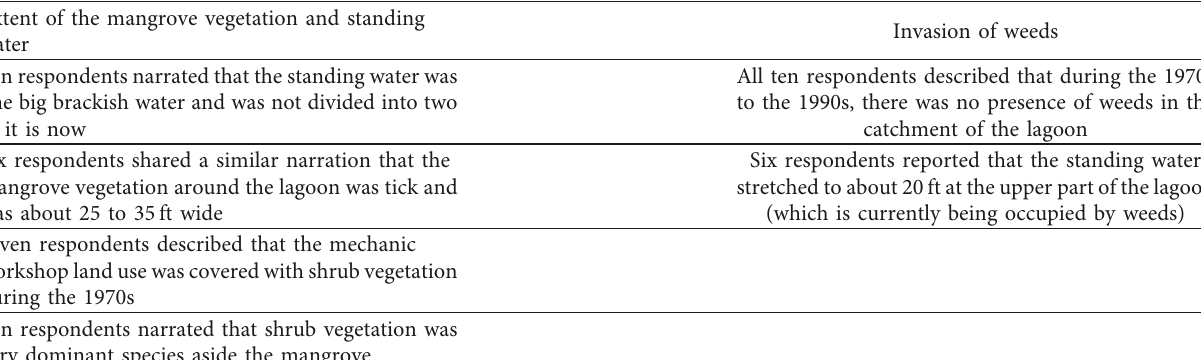
Table 1: Summary of Historic data from the field interview.